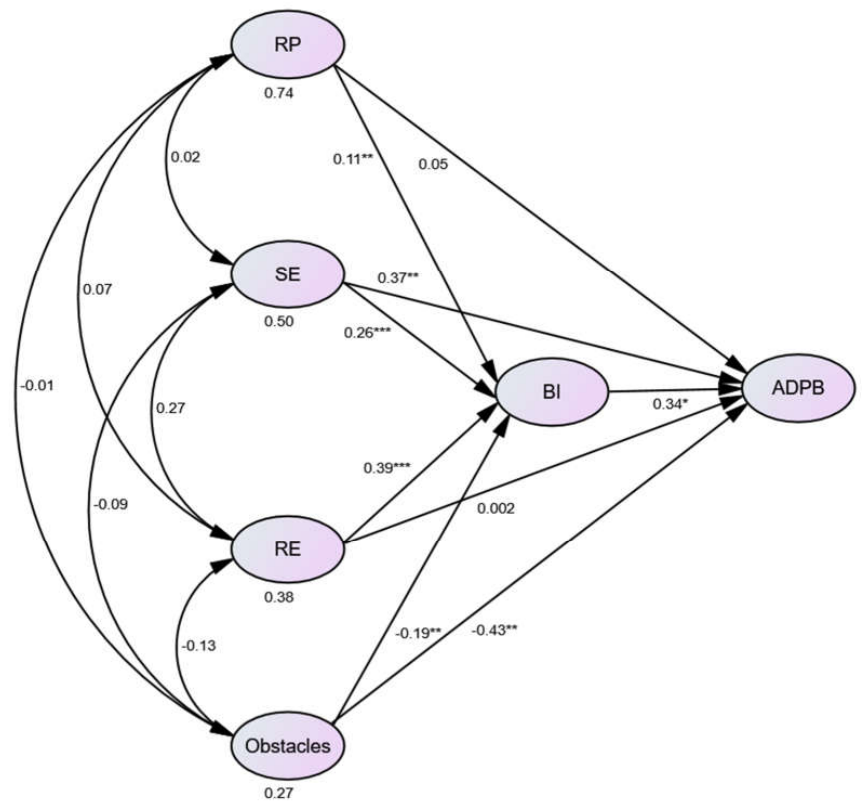
Figure 2. Structural equation modeling of the hypothesized model. * p ≤ 0.05. ** p ≤ 0.01. *** p ≤ 0.001; RP = risk perception; SE = self-efficacy; RE = response efficacy; BI = behavioral intention; ADPB = actual disaster preparedness behaviors.